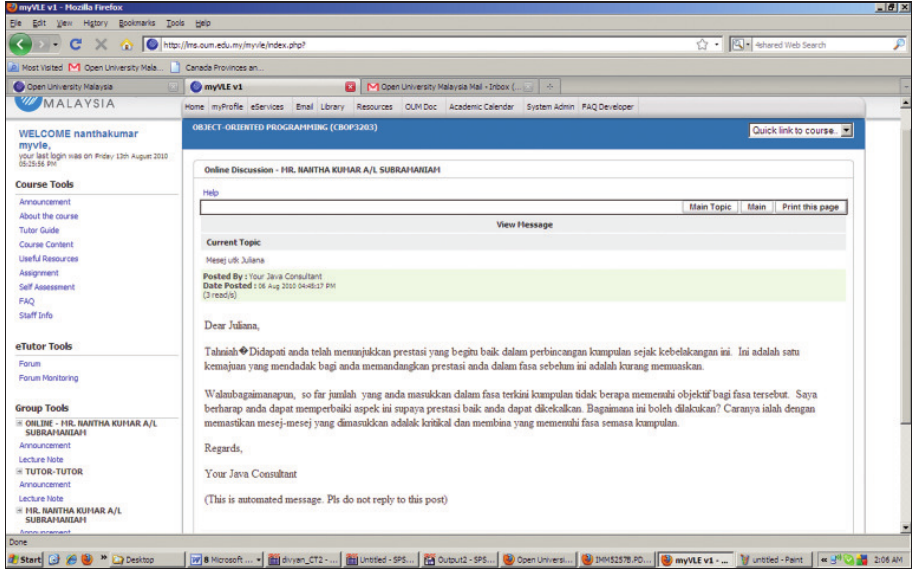
Figure 4 Example of message sent by the agent to a learner